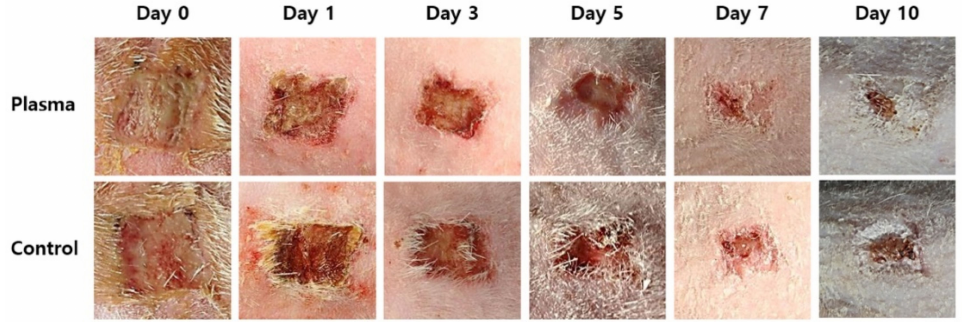
Figure 5. Representative gross photos of wound healing and closure in the plasma-treated and control groups by time.